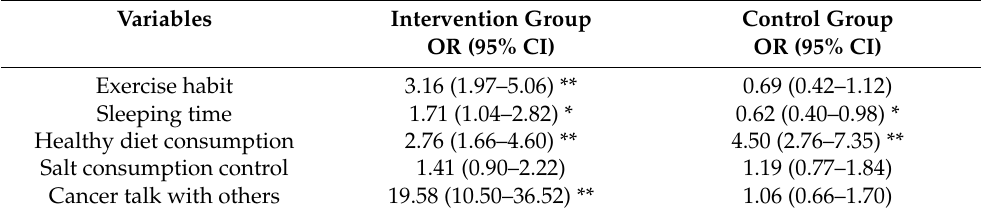
Table 3. Logistic regression on the change of healthy practice in 3-months among students.